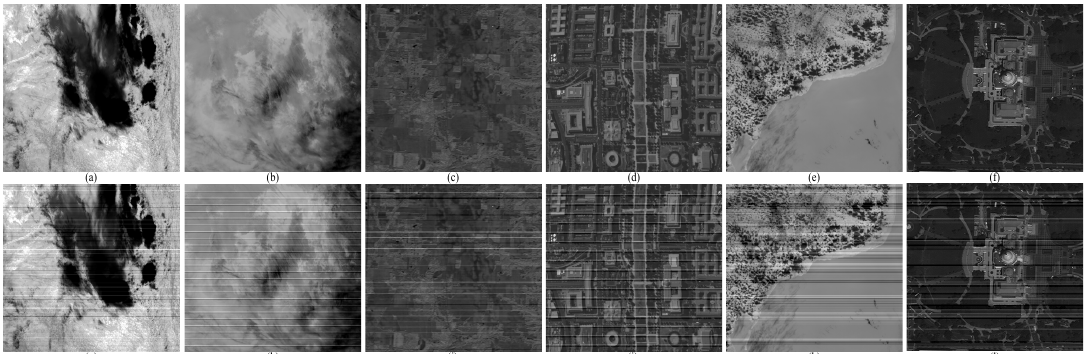
Figure 6. Simulated stripe. ( a ) Terra MODIS data S1. ( b ) Terra MODIS data S2. ( c ) Airborne Visible InfraRed Imaging Spectrometer (AVIRIS) hyperspectral data S3. ( d ) Washington DC Mall hyperspectral data S4. ( e ) Aqua MODIS data S5. ( f ) Washington DC multispectral data S6. ( g – l ) simulated stripe